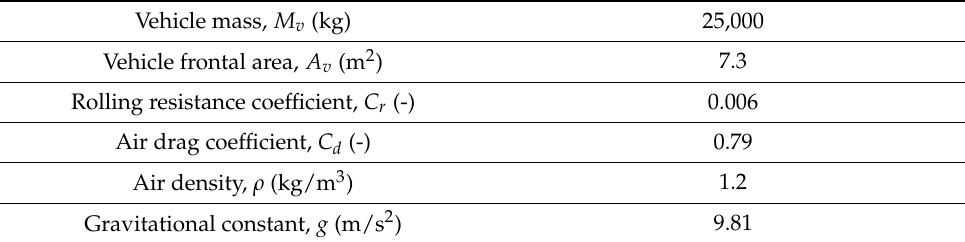
Table 2. Physical data of the city